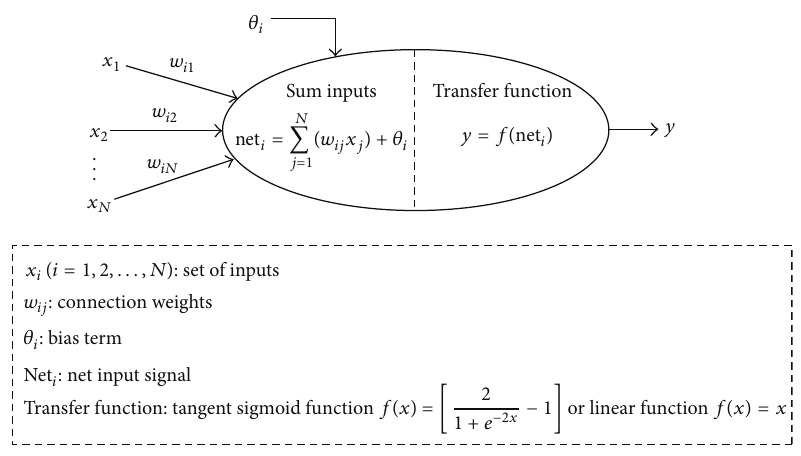
Figure 6: Summation and transfer functions of a typical artificial neuron.